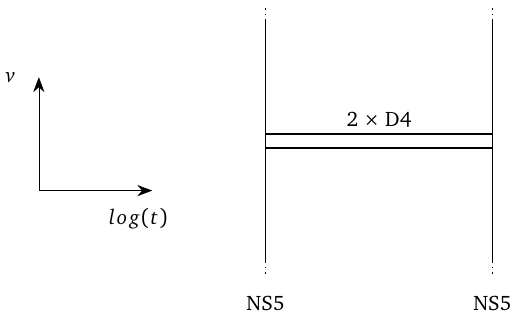
Figure 1: The Hanany-Witten setup realizing in Type IIA string theory the pure N = 2 su ( 2 ) SYM